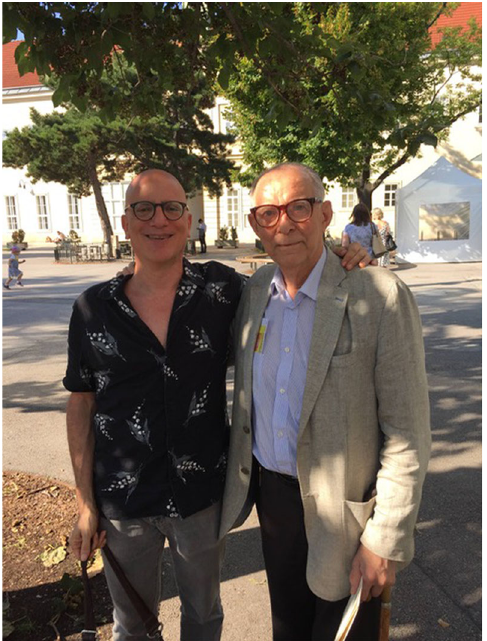
Fig. 2 David Sulzer with Oleh Hornykiewicz. David Sulzer with Oleh Hornykiewicz in front of the Narrenturm in Vienna, the earliest building to house psychiatric patients, during the Dopamine 2016 Conference, organized by Harald Sitte and Matthaus Willeit, which featured the Oleh Hornykiewicz 90 th birthday symposium. Photo- graph by Luigi